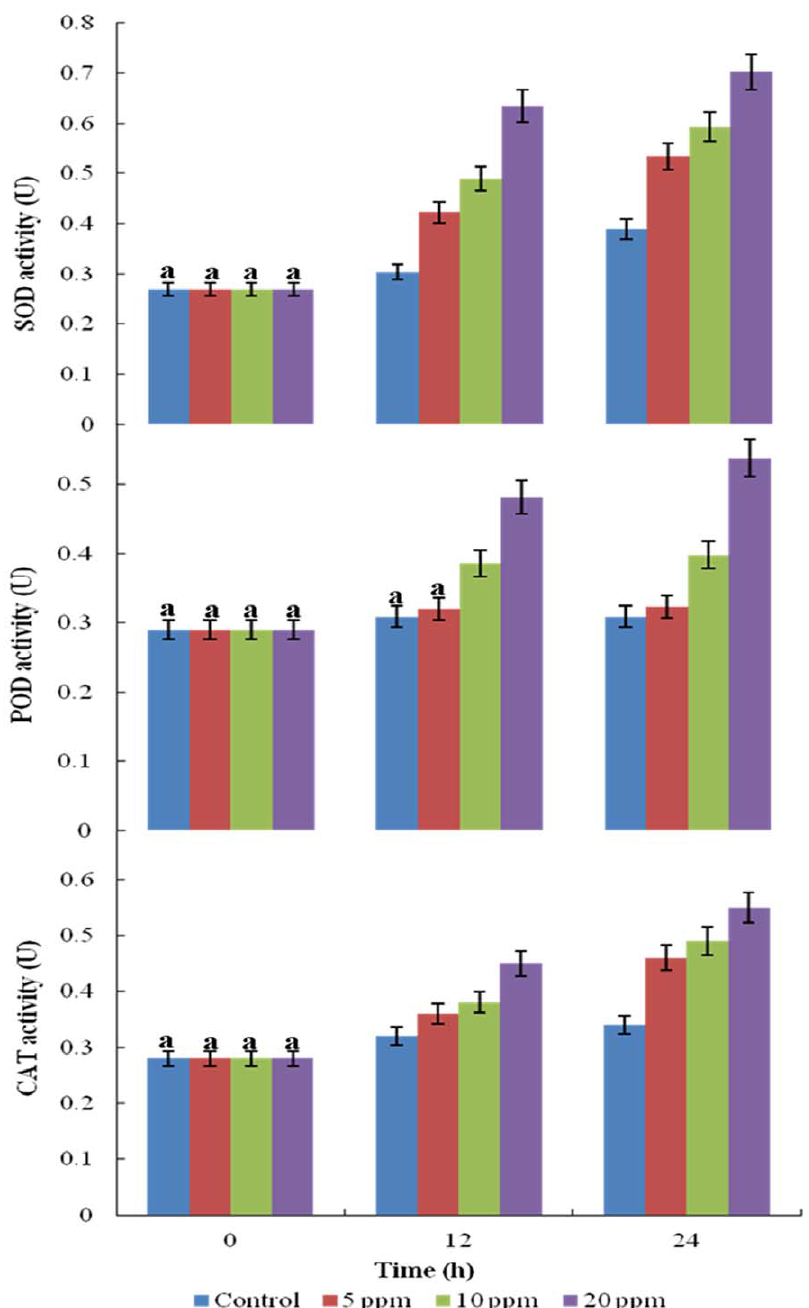
Figure 3. Activity of SOD, POD and CAT of Synechocysti s sp. strain PUPCCC 64 in presence of anilofos (mg L 2 1 ). All presented data are the mean values of three independent experiments 6 SD Data at different time intervals with same lower case letters are not significantly different from each other at the 95% confidence level (p , 0.05). doi:10.1371/journal.pone.0053445.g003 the microorganism exhibited 61, 44 and 25% growth as compared to control cultures in 5, 10 and 20 mg L 2 1 of anilofos, respectively. Growth inhibition by anilofos in Anabaena torulosa [46], butachlor, bensulfuron-methyl in Nostoc sp. [47,48], glyphosate in Anabaena sp., Leptolyngbya boryana, Nostoc punctiforme, and Microcystis aeruginosa [31,49], and, molinate and bentazon in Anabaena cylindrica and Nostoc muscorum [29,50,51] has recently been reported. These herbicides affect photosynthesis (bentazon), cell division and